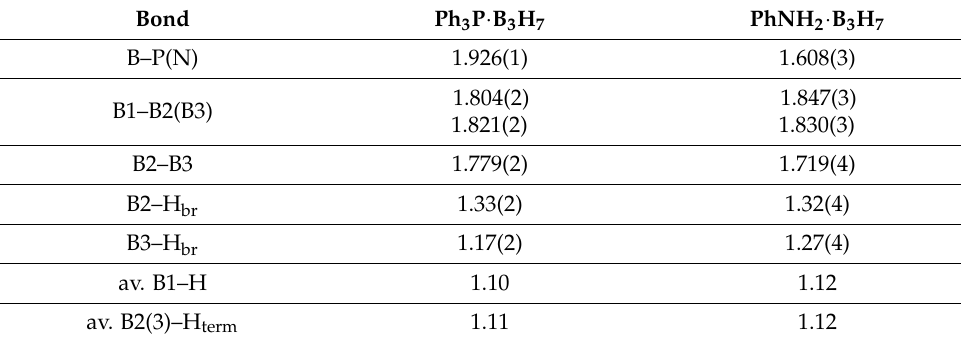
Table 1. The structural data obtained for Ph 3 P · B 3 H 7 and PhNH 2 · B 3 H 7.